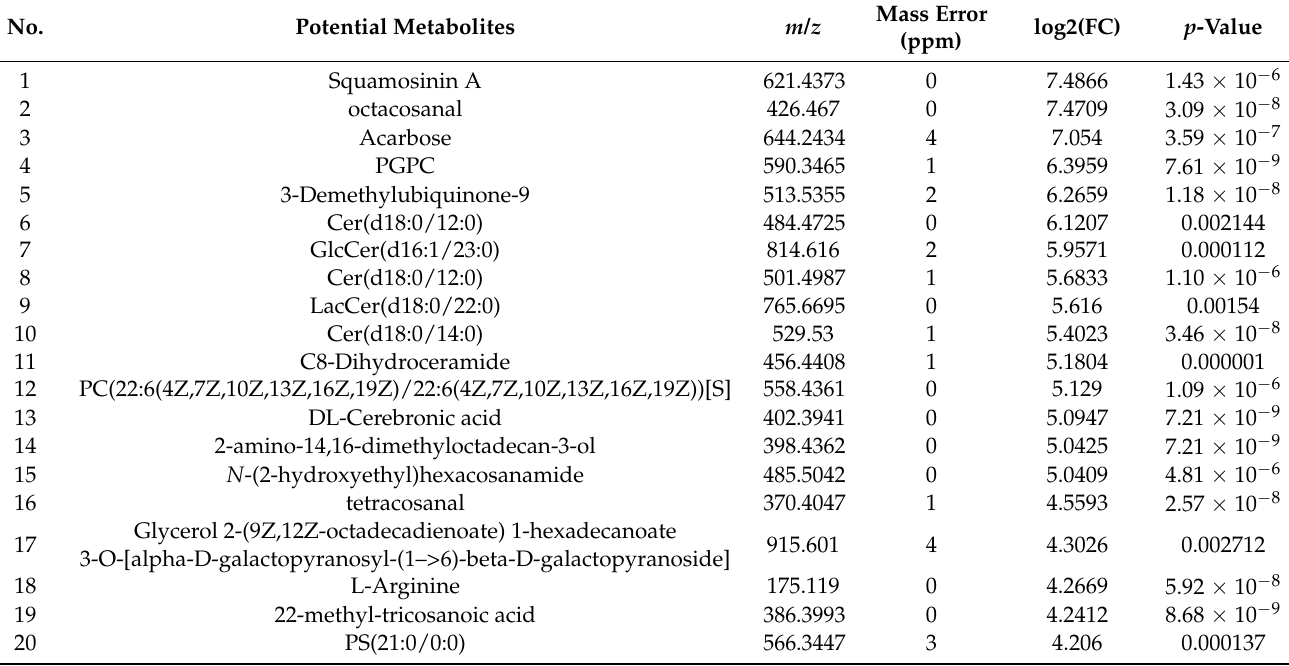
Figure 5. Volcano plots demonstrating differential metabolites of G. duodenalis after metronidazole treatment. Horizontal lines represent p -values equal to 0.01. Vertical lines represent fold changes equal to 1.5 and − 1.5, respectively. Blue and red refer to down- and up-regulated metabolites, respectively. Table 1. Top-twenty up-regulated metabolites of G. duodenalis after treatment with metronidazole.